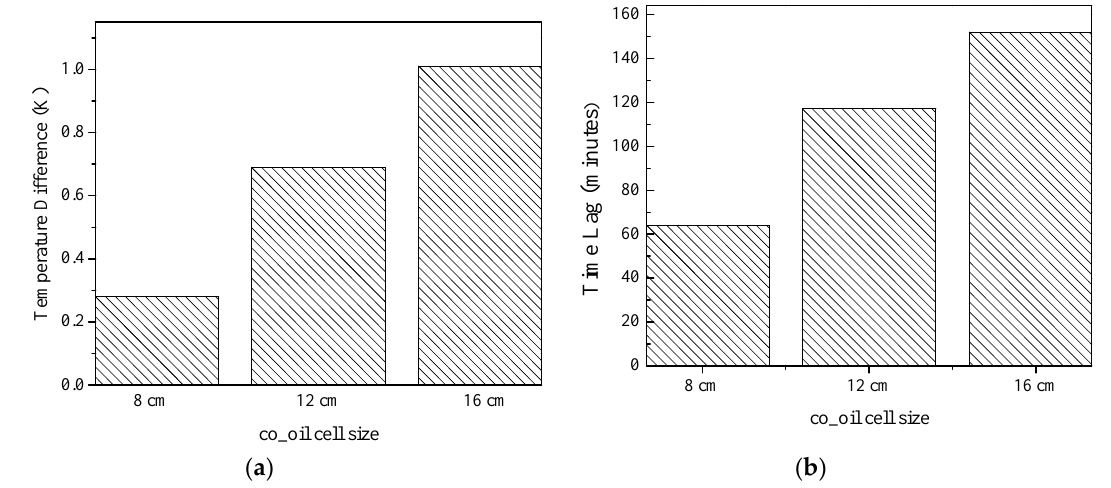
Figure 6. ( a ) The differences in maximum temperature between co_oil cells and air temperature and ( b ) its associated change in time lag, signifying the average time delay.